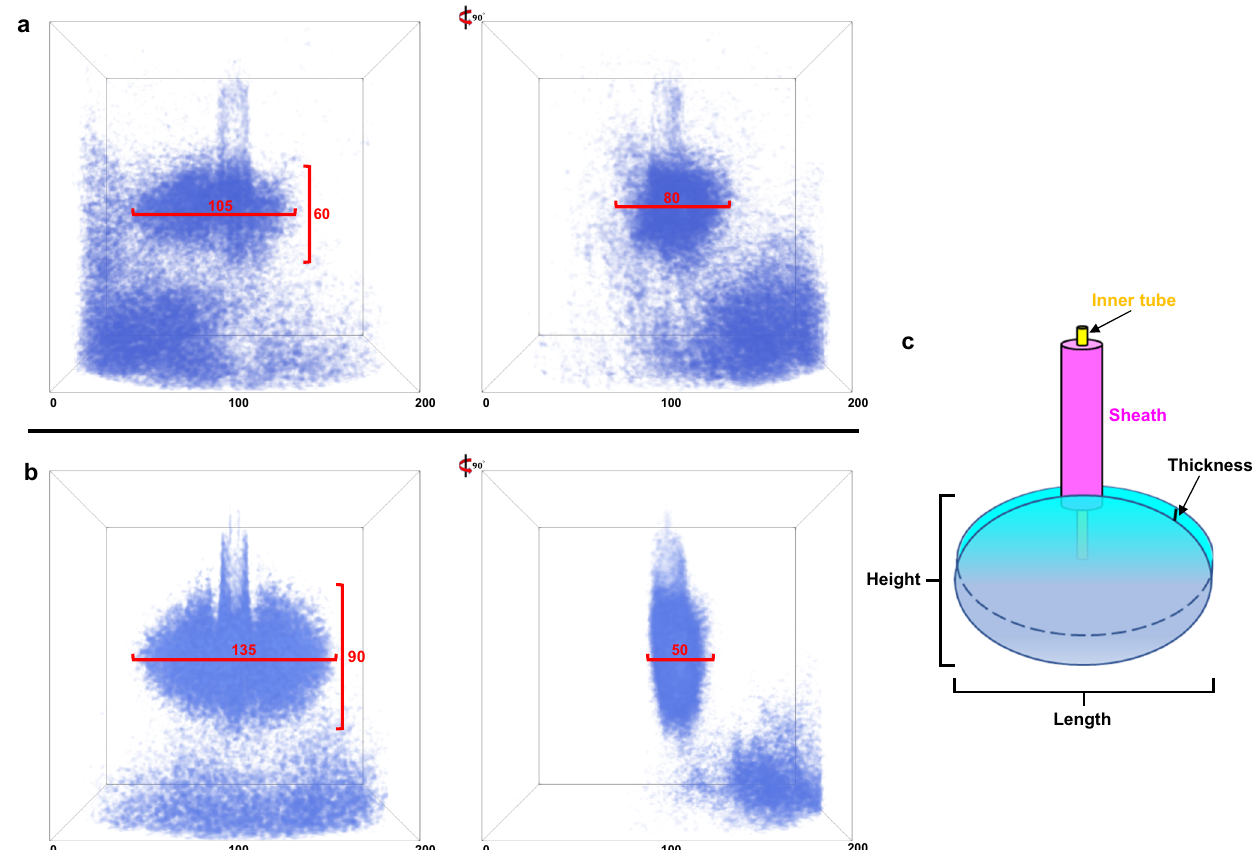
Fig. 6 | Averaged 3D structures oftail fi bers.a 3D superimposed structureof tail fi bersinpre-infectionphages.89tail- fi bersstructuresofpre-infectionphageswere aligned and averaged. The right image shows the side view of the structure after rotation by 90°. Both the outer box and red line are scale bars with pixel unit. The outer square box size is 200 pixels, pixel size is 1.312nm. The size of the tail- fi ber structure is ~137.8nm in length, 78.7nm in height, and 104.9nm in thickness. b 3D